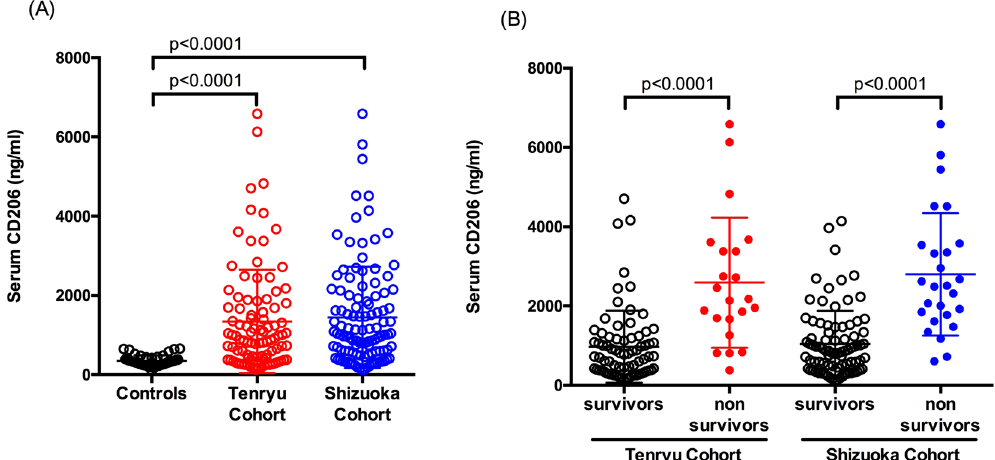
Figure 1. Serum concentrations of sCD206 in patients with pulmonary tuberculosis (PTB) and control subjects ( A ), in PTB patients with non-survivors and survivors ( B ). P values were determined by the Mann-Whitney U test, and the Kruskal-Wallis test followed by Dunn’s multiple comparison test.